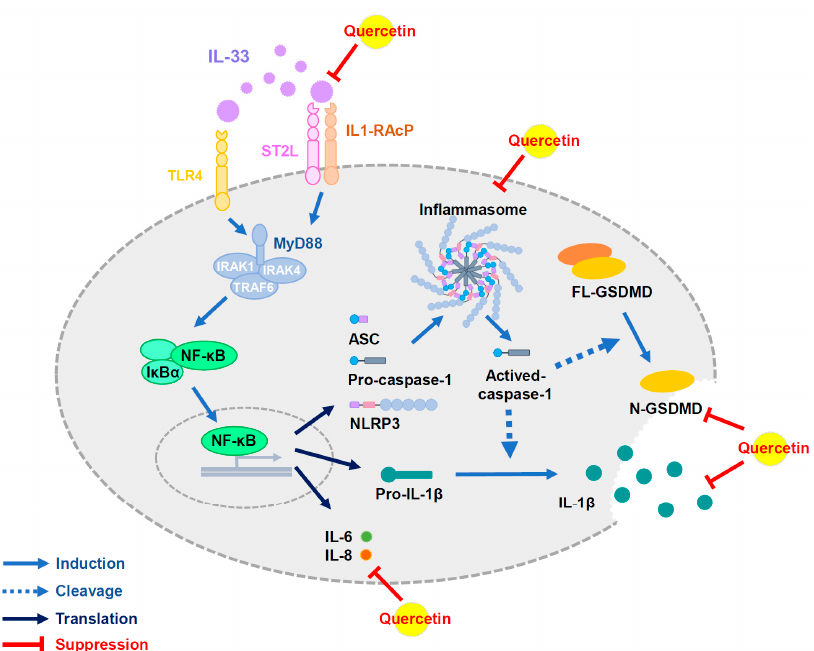
Figure 8. Schematic representation of the mechanisms through which quercetin exerts its potential effects in lupus nephritis-induced renal injury progression. Quercetin suppresses IL-33/ST2 signaling pathway, inhibits inflammasome and pyroptosis-related proteins expression, and reduces the secretion of IL-6 and IL-8 cytokines. Abbreviations: IL-33, interleukin-33; ST2, suppression of tumorigenicity-2; TLR4, toll-like receptors 4; IL-1RAcP, IL-1 receptor accessory protein; MyD88, myeloid differentiation primary response protein 88; IRAK, IL-1R-associated kinase; TRAF6, tumor necrosis factor receptor-associated factor 6; I κ B α , inhibitor of nuclear factor κ B α ; NF- κ B, nuclear factor-kappa B; GSDMD, gasdermin D; ASC, apoptosis-associated speck-like protein containing a caspase recruitment domain; NLRP3, NOD-like receptor family pyrin domain-containing protein 3; caspase-1, cysteine aspartate-specific proteases-1.